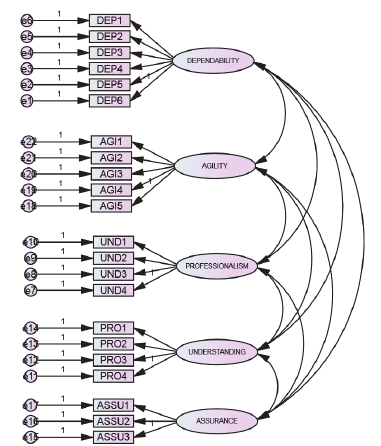
Fig. 3. Theoretical framework for development of Employee Service Quality Scale